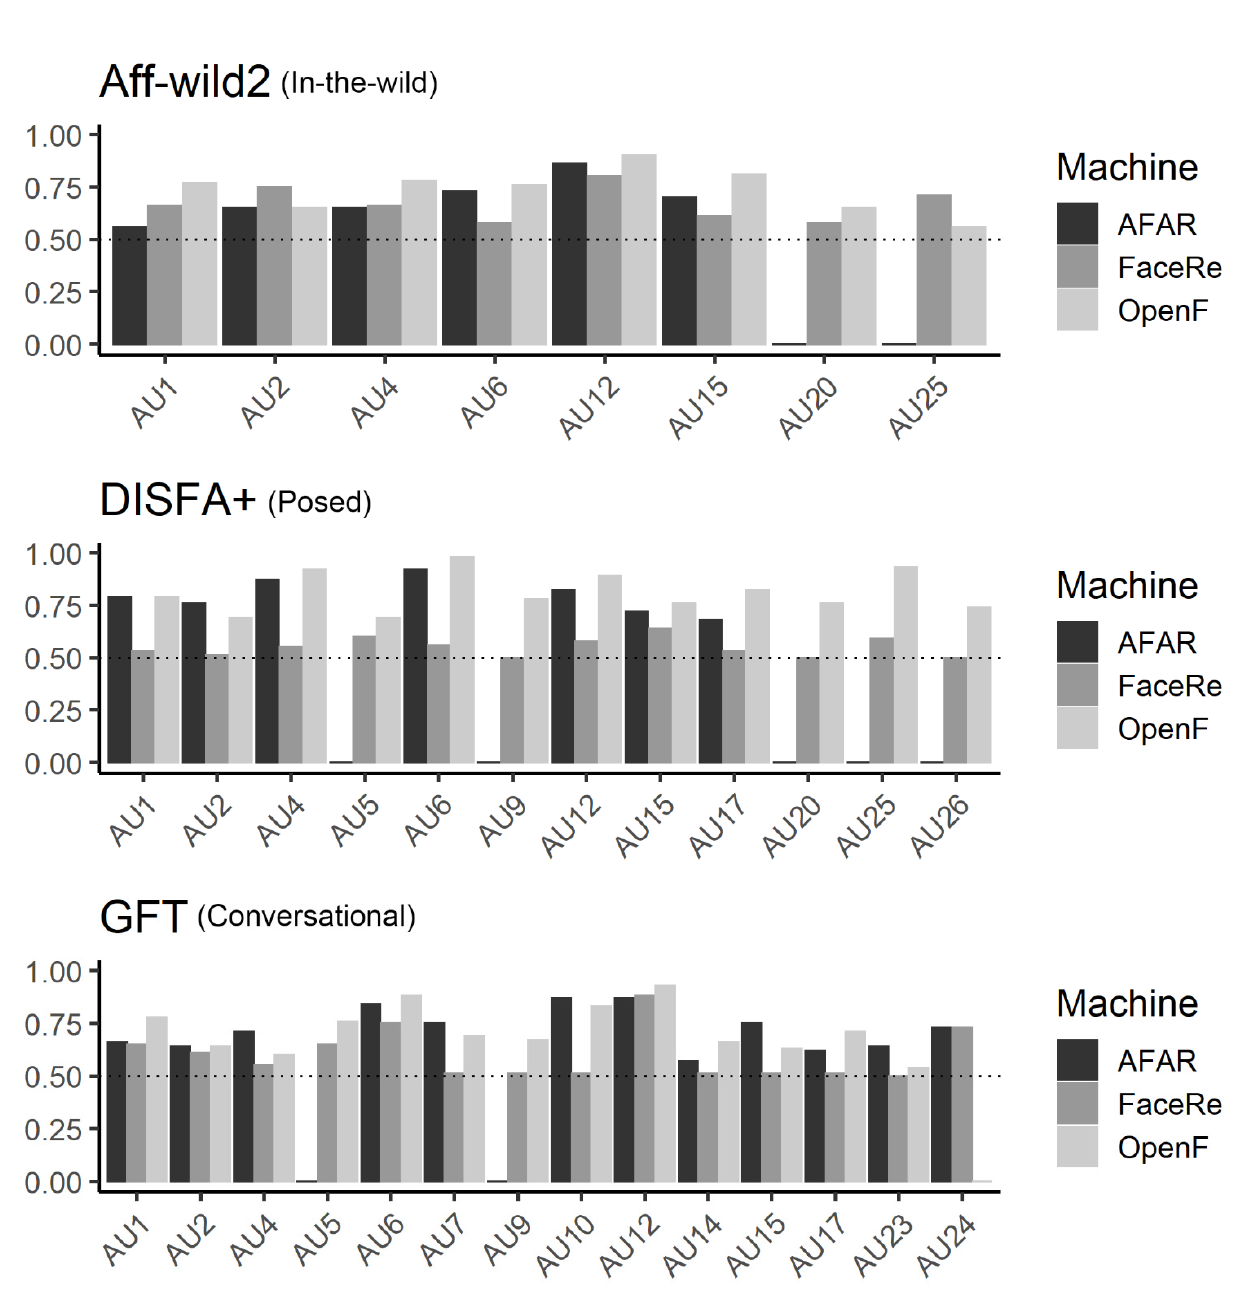
Figure 2. Average scores for each predicted AU, for all databases and machines. Dotted line represents random performance (i.e., AUC = 50). A zero value indicates an AU type that was not provided by the algorithm (e.g., AU20 in Aff-wild2 *AFAR).